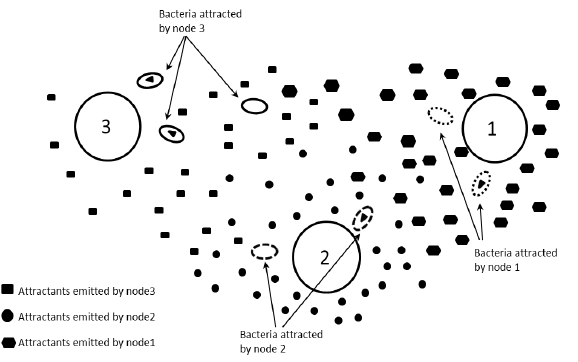
Figure 1: Example of bacterial nanonetwork